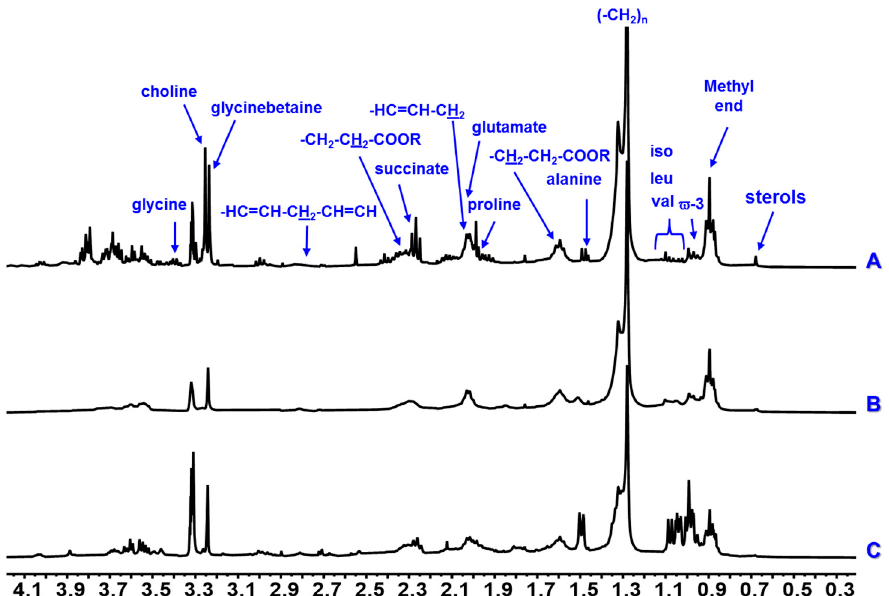
Figure 3. 1 H HR-MAS NMR spectra (400 MHz, MeOD) of the microalgae N. oceanica (A), C. muelleri (B) and C. weissflogii (C). In blue, the metabolites or types of hydrogens identified are indicated. According to the 1 H HR-MAS NMR spectra of marine microalgae C. muelleri , C.